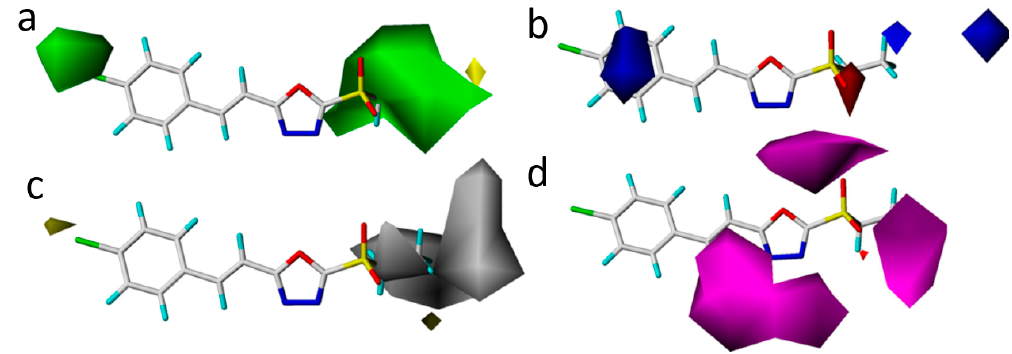
Figure 8. CoMSIA contour maps of steric ( a ), electrostatic ( b ), hydrophobic ( c ), and H-bond acceptor ( d ) fields.